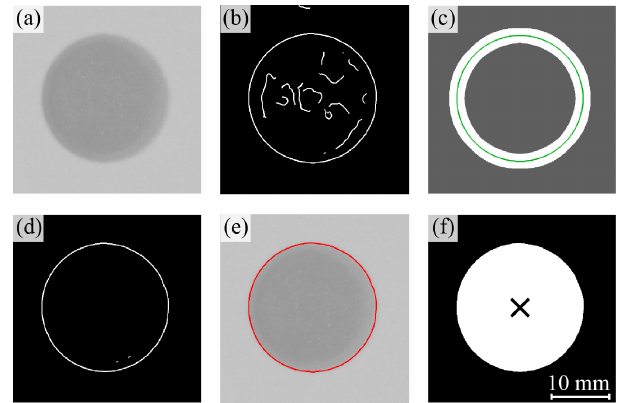
Figure 10. Steps of adapted contour detection: (a) original section of melting pool (Con 20 , 10 ), (b) detected edges by Canny algorithm, (c) mask based on the nominal shape, (d) remaining edges after area delimitation, (e) longest, final edge projected on the original image, and (f) segmented melting pool area including the calculated